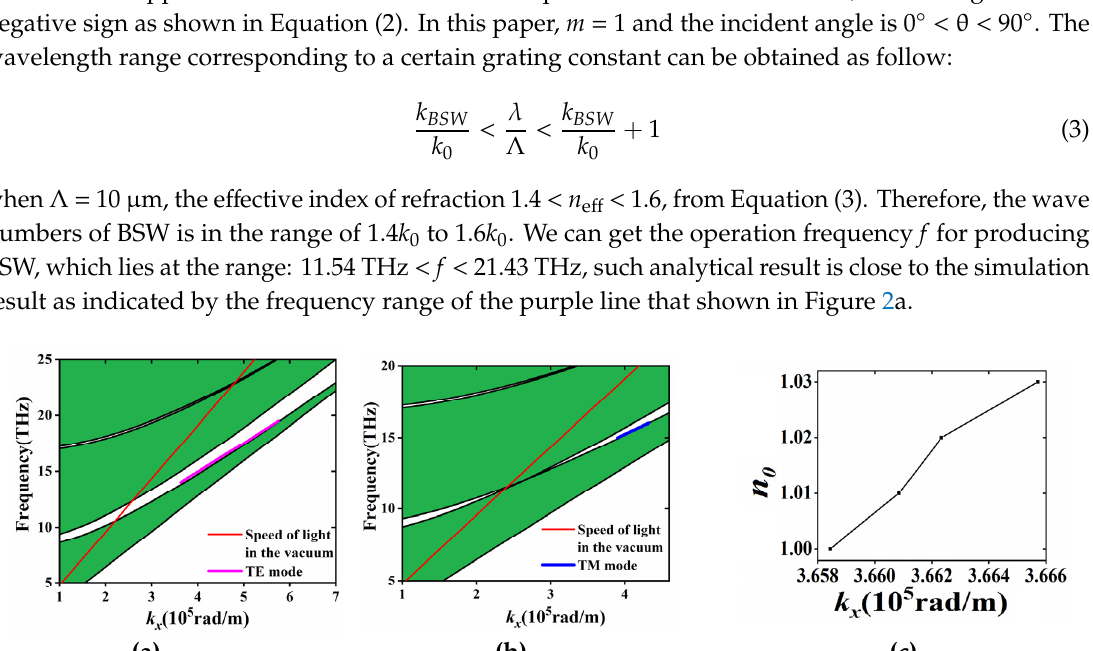
Figure 3. ( a )Electric field distribution in the y direction in the sensor Bloch surface wave (BSW) mode with the incident angle of 60°. ( b ) The electric field component in the z-direction along the y -direction, which is the top edge of the structure in ( a ) (the dark gray part is the position of the grating).